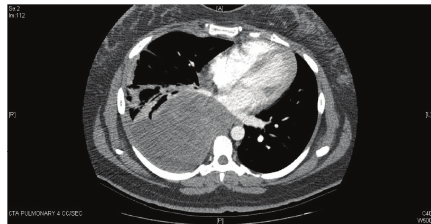
Figure 1: Helical CT with contrast demonstrating a large partially calcified mass within right hemithorax with broad-base apposition to mediastinum (24DEC2009).